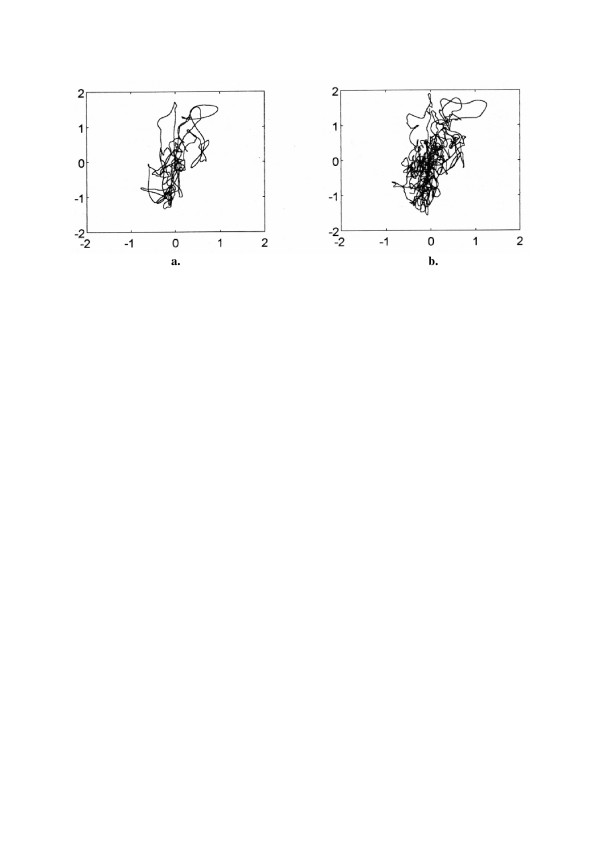
Example of COM (a.) and COP (b.) signals recorded simultaneously in a subject 74 years old during quiet stance in a 2-minutes trial; displacements measured in millimeters.